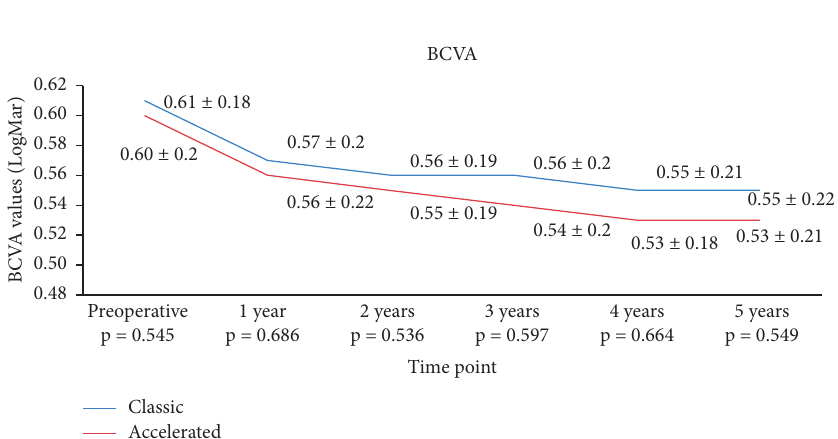
Figure 7: Evolution of UCVA in both groups.